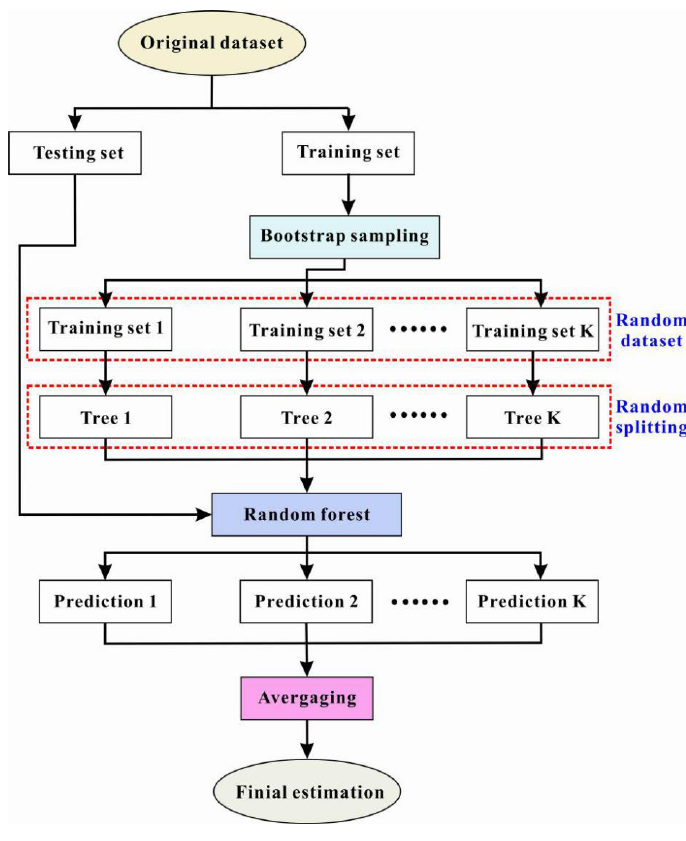
Figure 4. Illustration of RDT and RF [31].